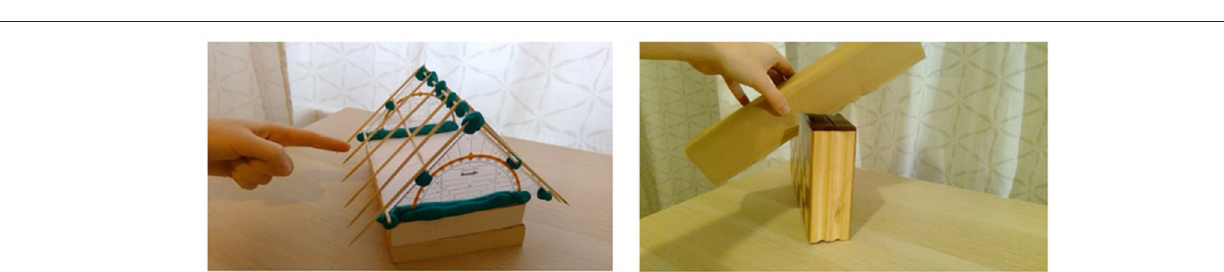
FIGURE 3 | Student Q (left) and Student M (right) chose different elements to explain similar concepts.